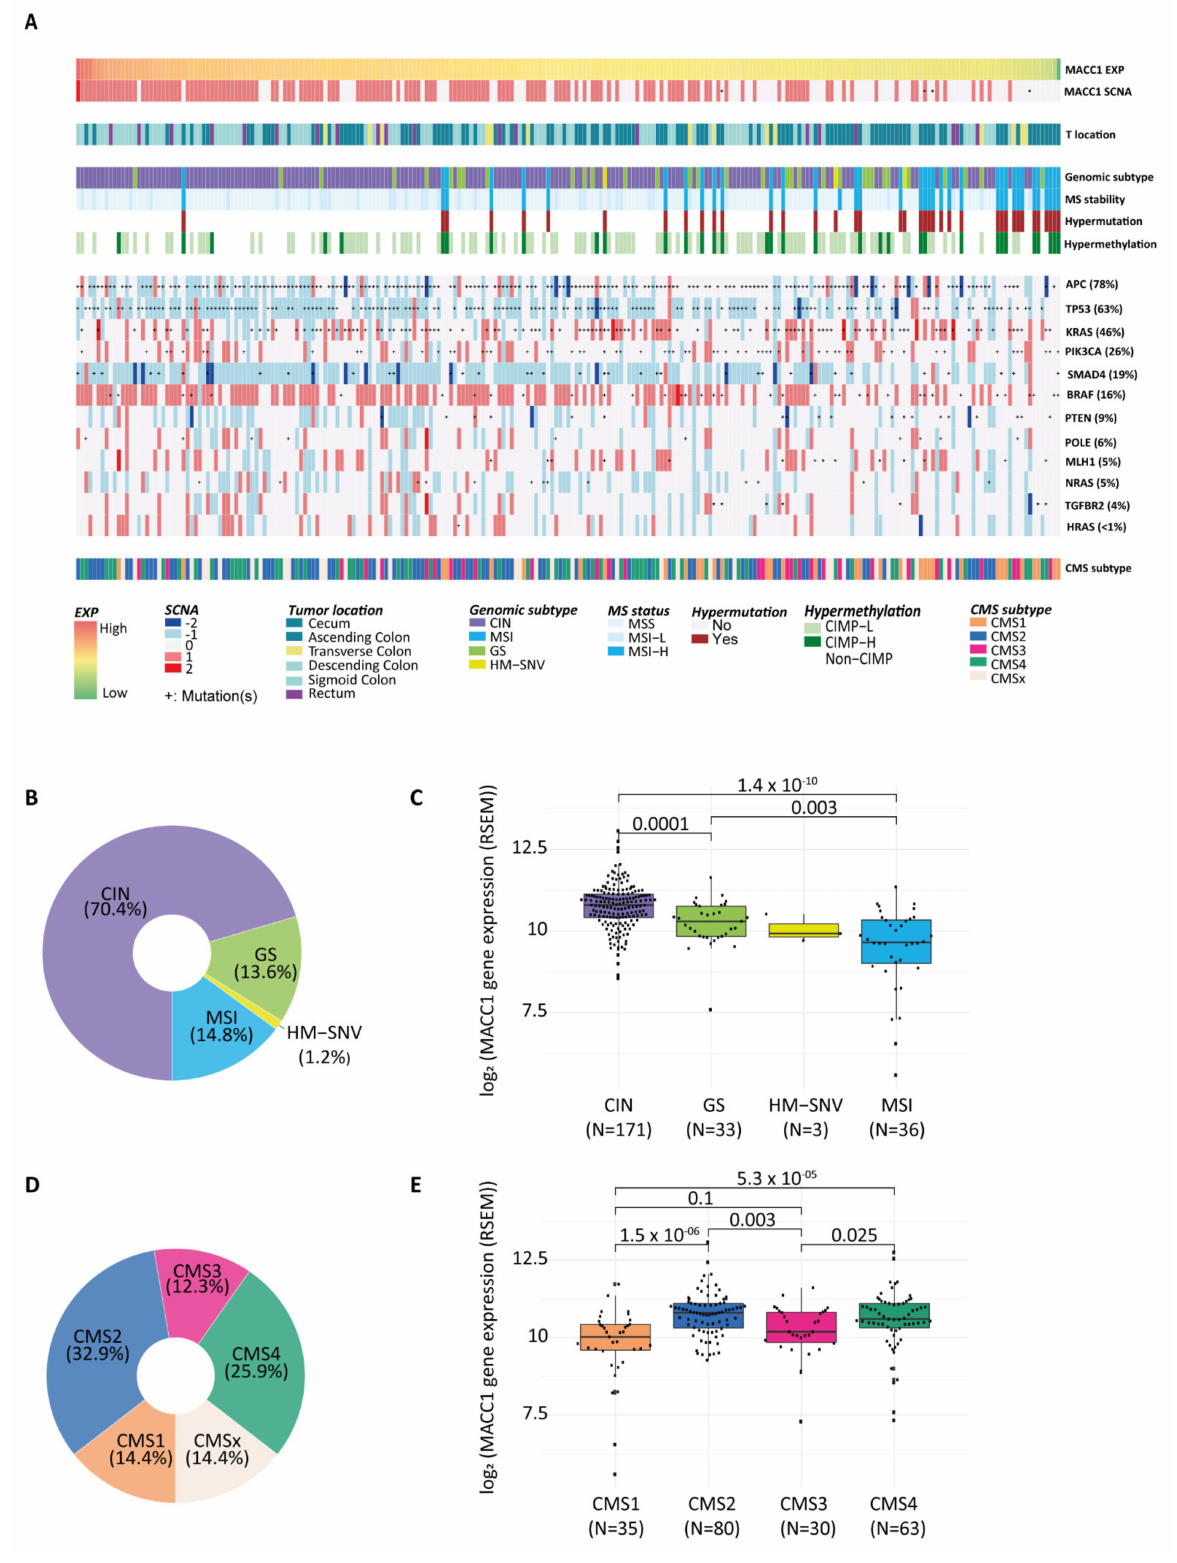
Figure 3. MACC1 mRNA expression and CRC molecular subtypes. ( A ), Landscape showing the association of MACC1 SCNA and expression according major colorectal-cancer-associated subtypes including MSI status, genomic subtypes, hypermutation status, hypermethylation, consensus